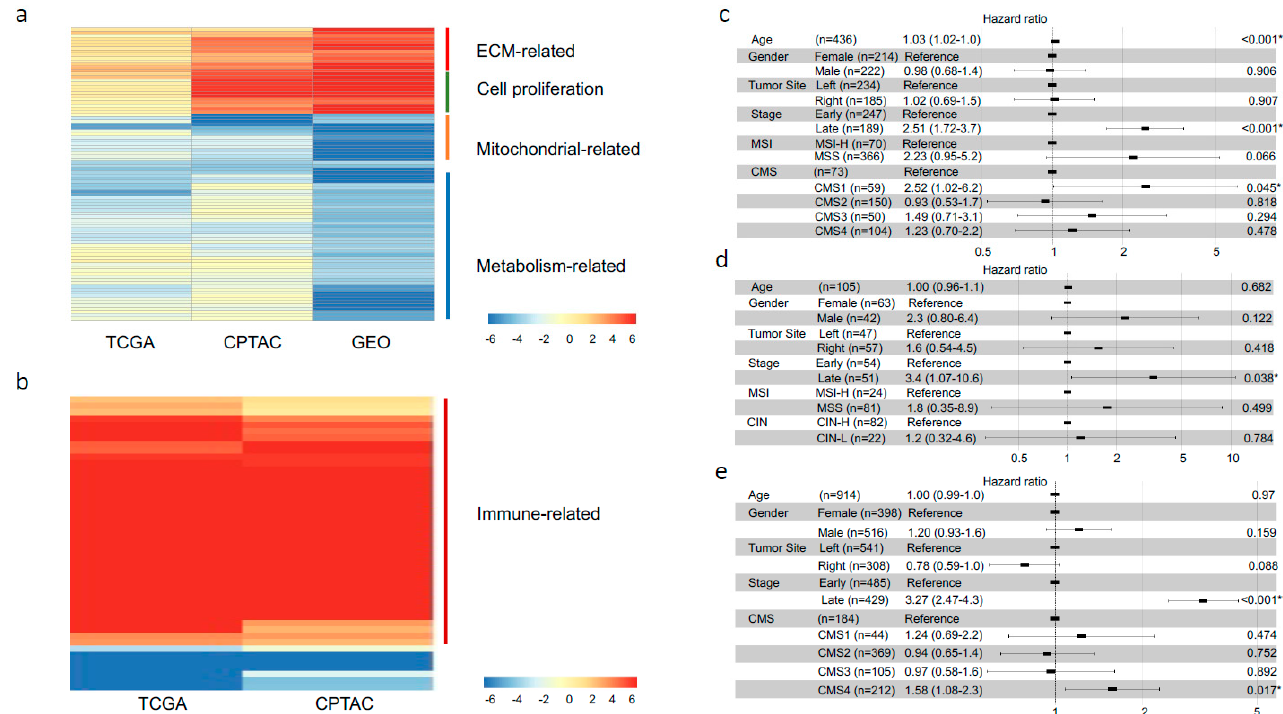
Figure 1. Molecular and clinical relevance of three previous CRC subtyping systems. ( a ). A p -value heatmap representing dysregulated gene sets between advanced- and early-stage of CRC (early-stage was used as control). ( b ). A p -value heatmap representing dysregulated gene sets between MSI-H and non-MSI-H CRC (non-MSI-H group was used as control). In the heatmaps, columns correspond to different cohorts, and rows to gene sets. Values in the heatmaps were − log10 (FDR adjusted p -value) transformed. Red color indicates up-regulated gene sets, and green means down-regulated gene sets in the control groups. Gene sets were grouped into different functional categories, with representative functional names shown on the right hand of the heatmaps, respectively. Forest plots of Cox PH regression models illustrated the HRs, 95% CIs and log-rank p -values for different subtyping systems (stage, MSI, CMS, etc.) and confounder factors (age, gender, etc.) for DFS in the TCGA ( c ), CPTAC ( d ), and GEO ( e ) cohorts. Log-rank p -value significance levels were given by stars: * <0.05, and ** <0.01.